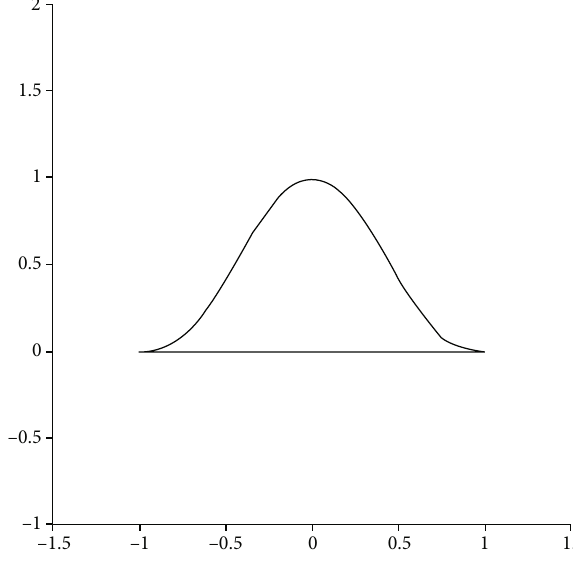
Figure 2: The set in Counterexample